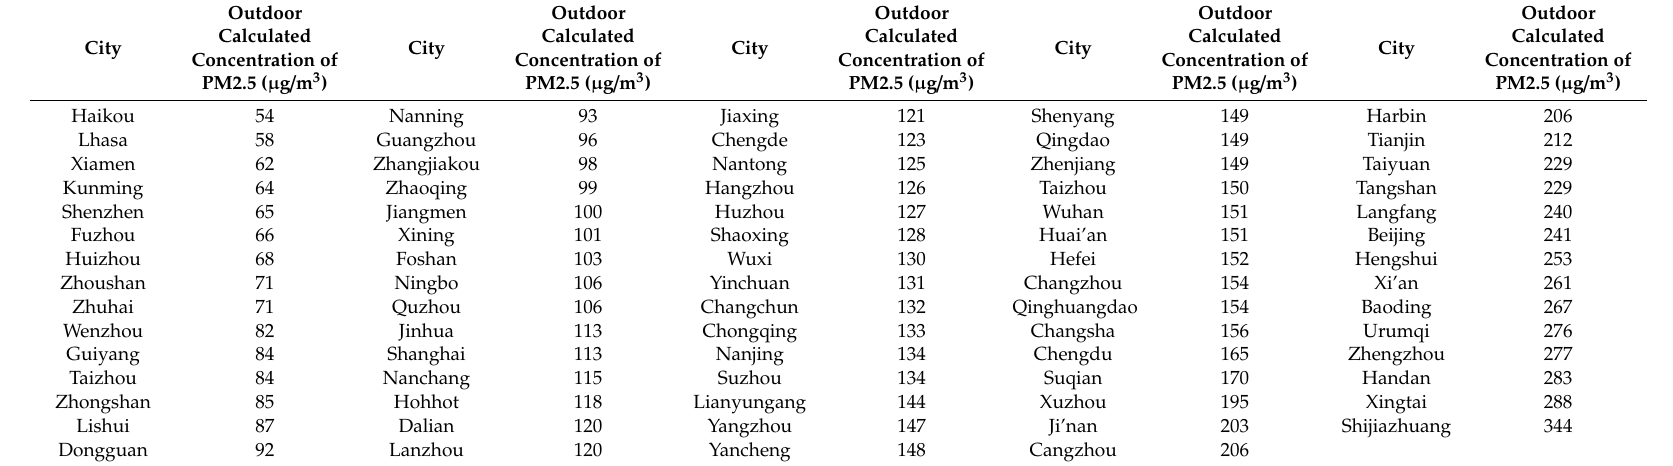
Table 1. Seventy-four cities’ outdoor calculated concentrations of PM2.5 in